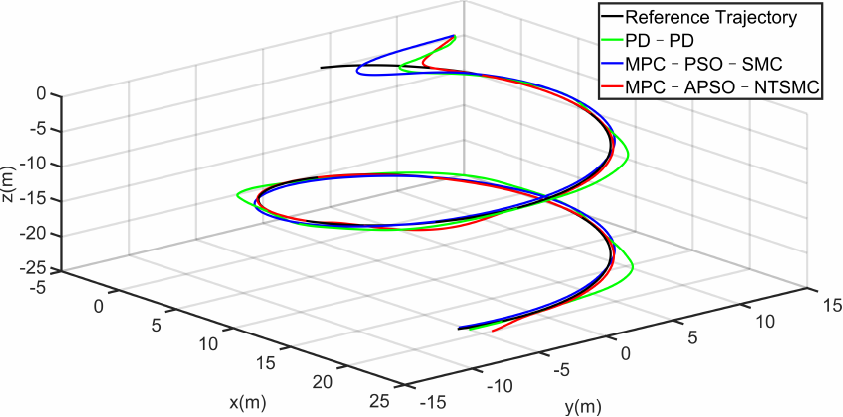
Figure 13. AUV spiral trajectory tracking with random disturbance for Case 1.